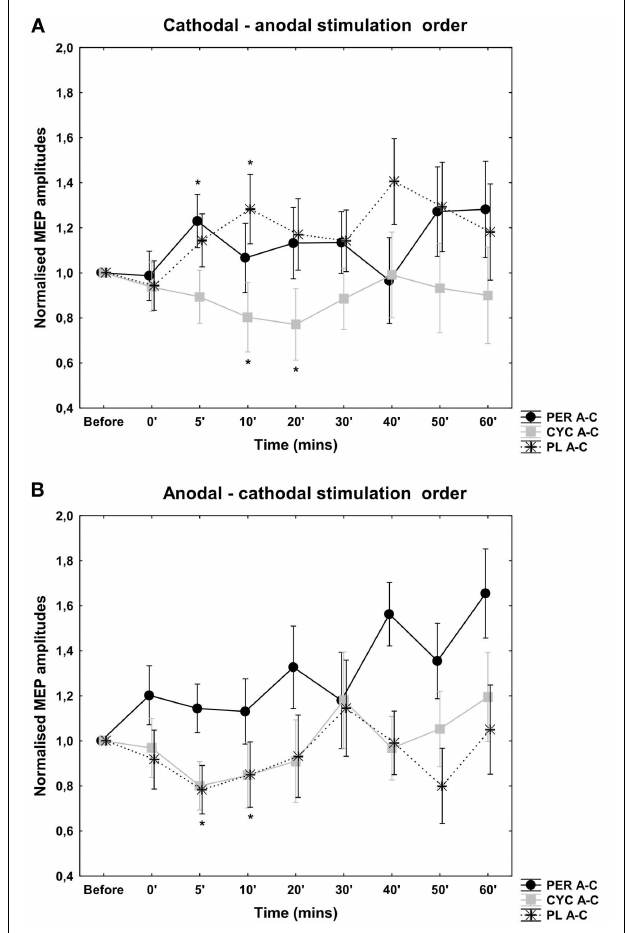
FIGURE 1 | Effects of antagonistic cathodal-anodal (A) and anodal-cathodal (B) tDCS in conjunction with PER, CYC, and PLC control. MEP amplitudes are given as mV, vertical bars indicate SEM.With regard to the PLC condition the order of each short-duration antagonistic tDCS application is the predominating factor in modulating short-duration tDCS aftereffects. A tendency toward excitability enhancement was seen after PER administration in the cathodal-anodal stimulation order. After anodal-cathodal tDCS an increase in cortical excitability is also evident, but was not significant. d-CYC administration resulted in a decrease in cortical excitability regardless of the orientation of stimulation.